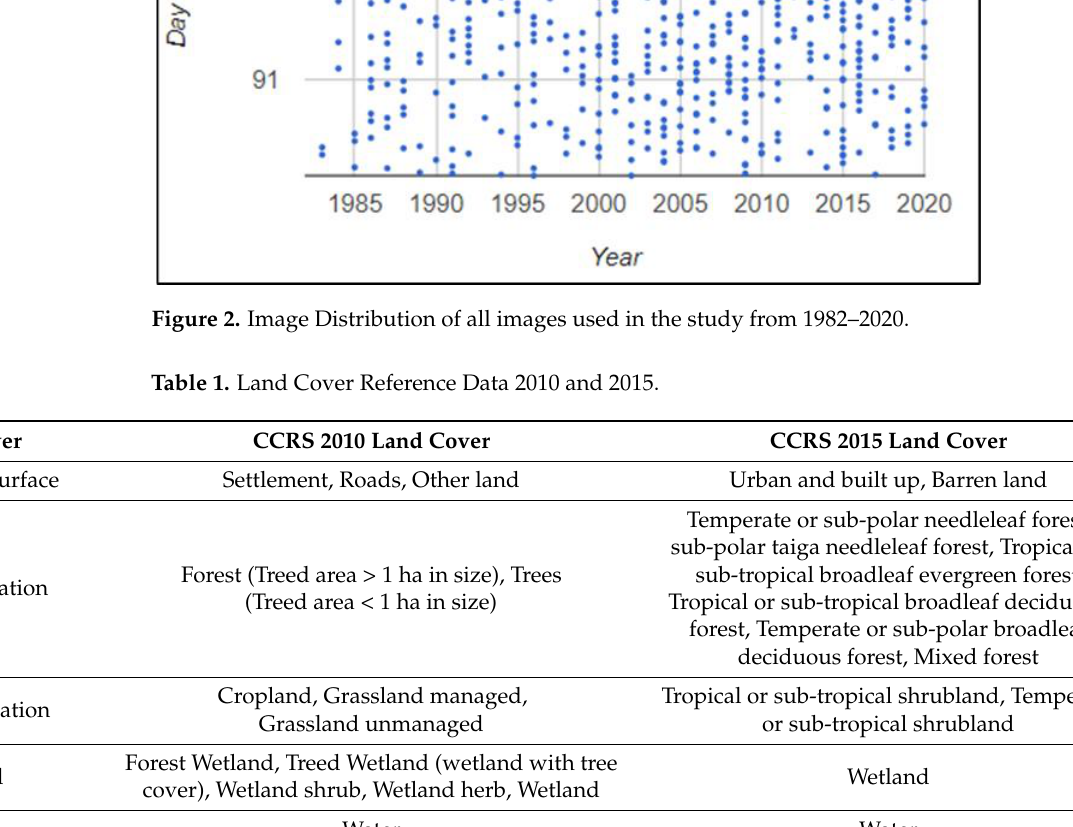
Table 1. Land Cover Reference Data 2010 and 2015 .